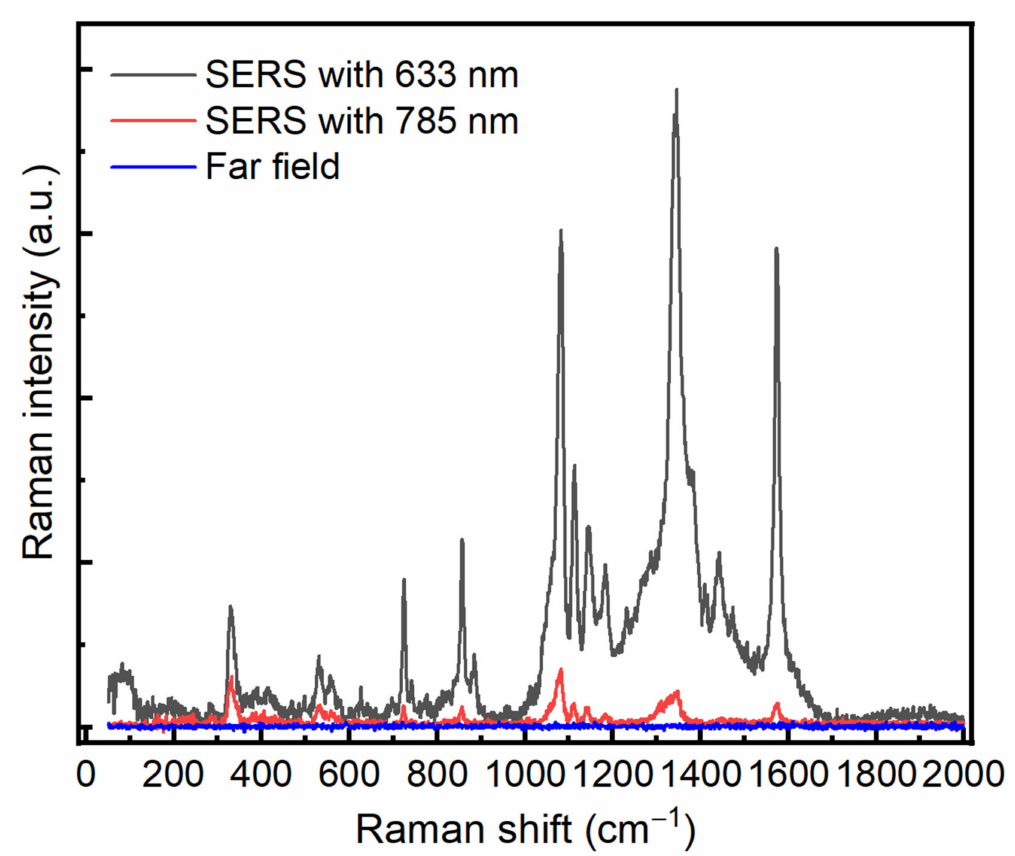
Figure 3. SERS spectra of 4-NTP on Au/Ag substrate with different excitation wavelengths, 632.8 nm (black color) and 785 nm (red color). Blue spectrum represents the Raman spectrum of 4-NTP on Au/Ag where there is no enhancement. Both wavelengths, 785 nm and 632.8 nm, are used. An integration time of 1 s, power 0.2 mW, ×